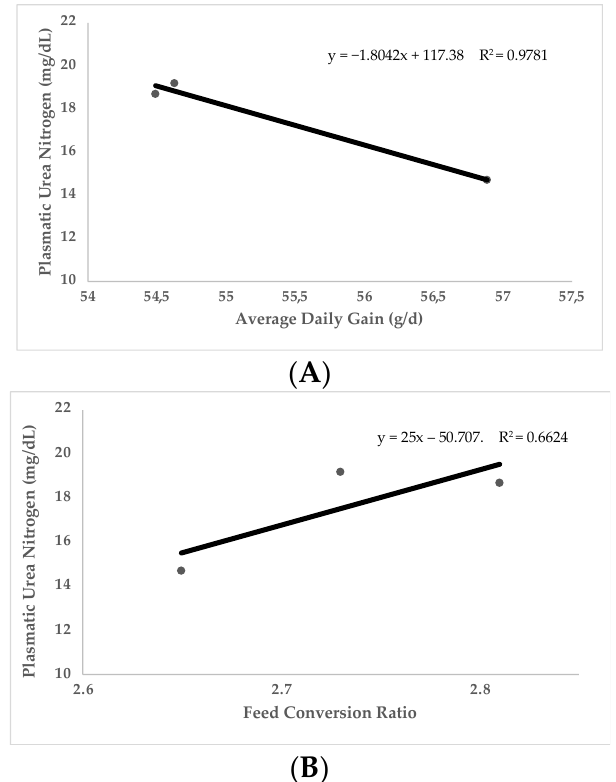
Figure 2. Relationship of plasmatic urea nitrogen (PUN) with average daily gain ( A ) and with feed conversion ratio ( B ). Data obtained from four published studies in growing rabbits [2,60,87,89].